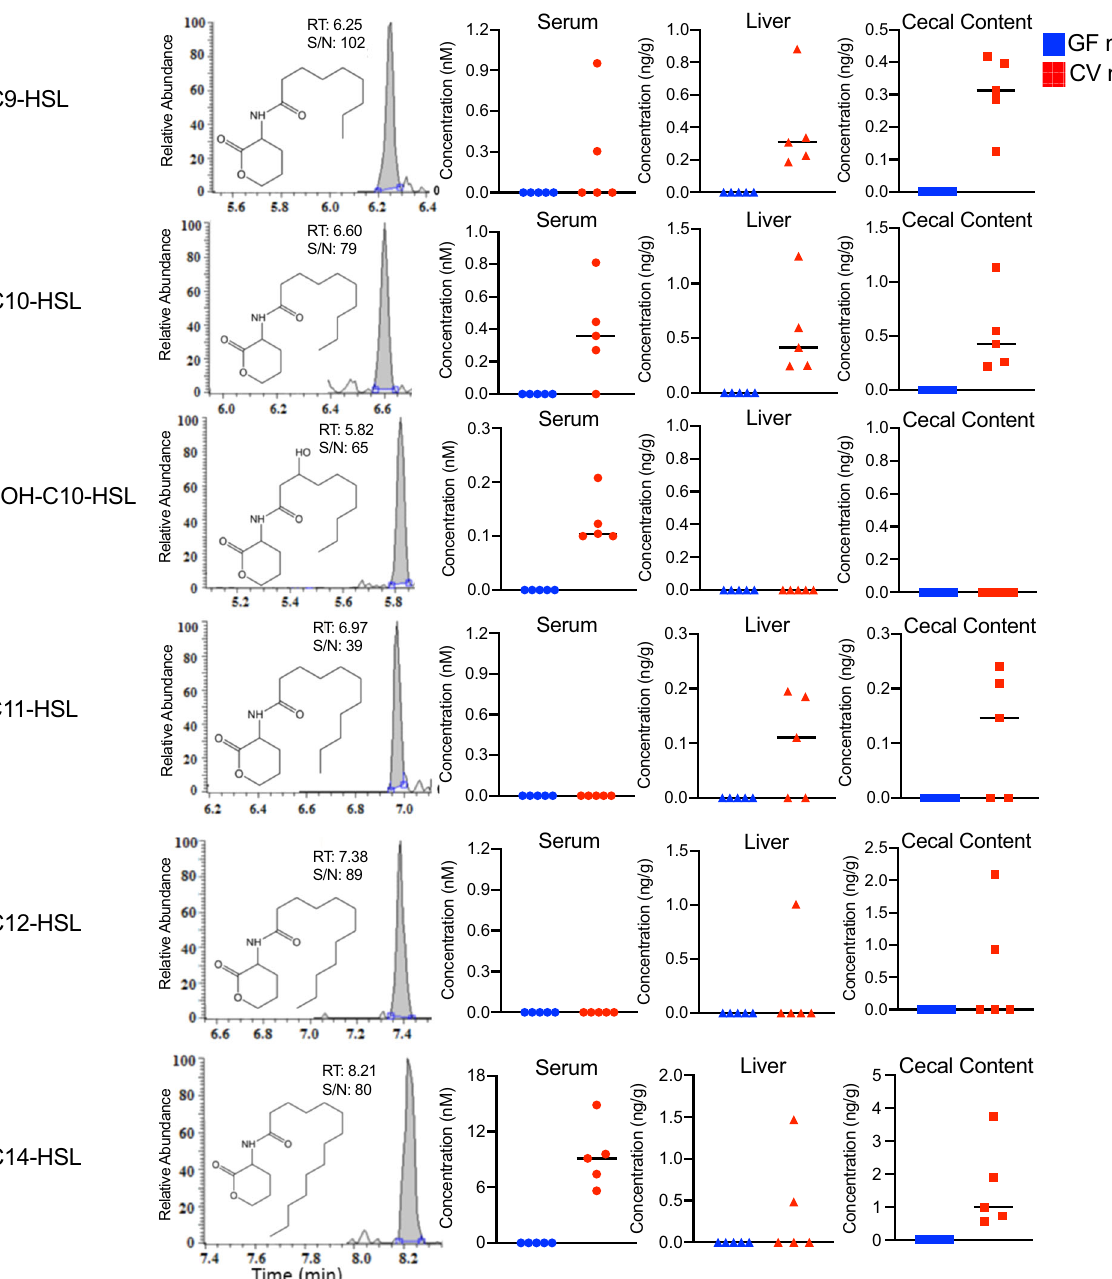
Fig. 3 Typical UPLC-ESI-MS/MS chromatograms of long side-chain AHLs (C9-HSL, C10-HSL, 3OH-C10-HSL, C11-HSL, C12-HSL, and C14- HSL) detected in biological samples and the corresponding concentrations in the biological samples (cecal contents, sera, and livers) of conventional (CV) and germ-free (GF) mice. RT retention time, S/N signal-to-noise